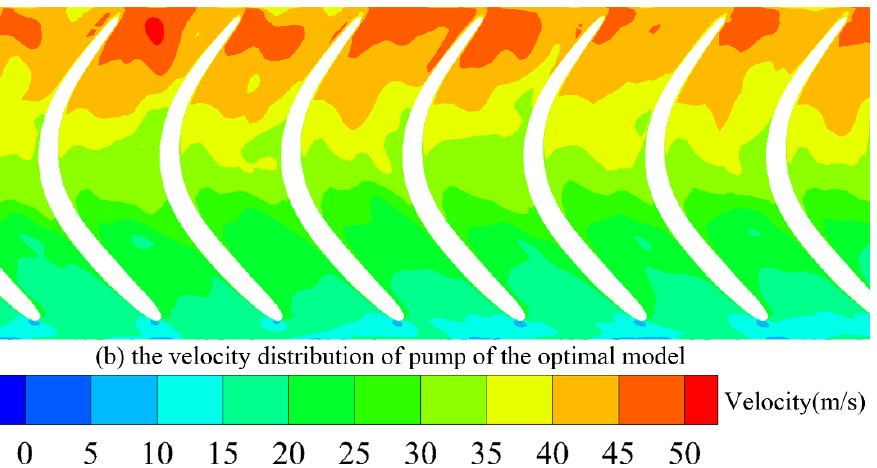
Figure 17. Comparison of pump flow field before and after optimization under peak-efficiency operating condition.